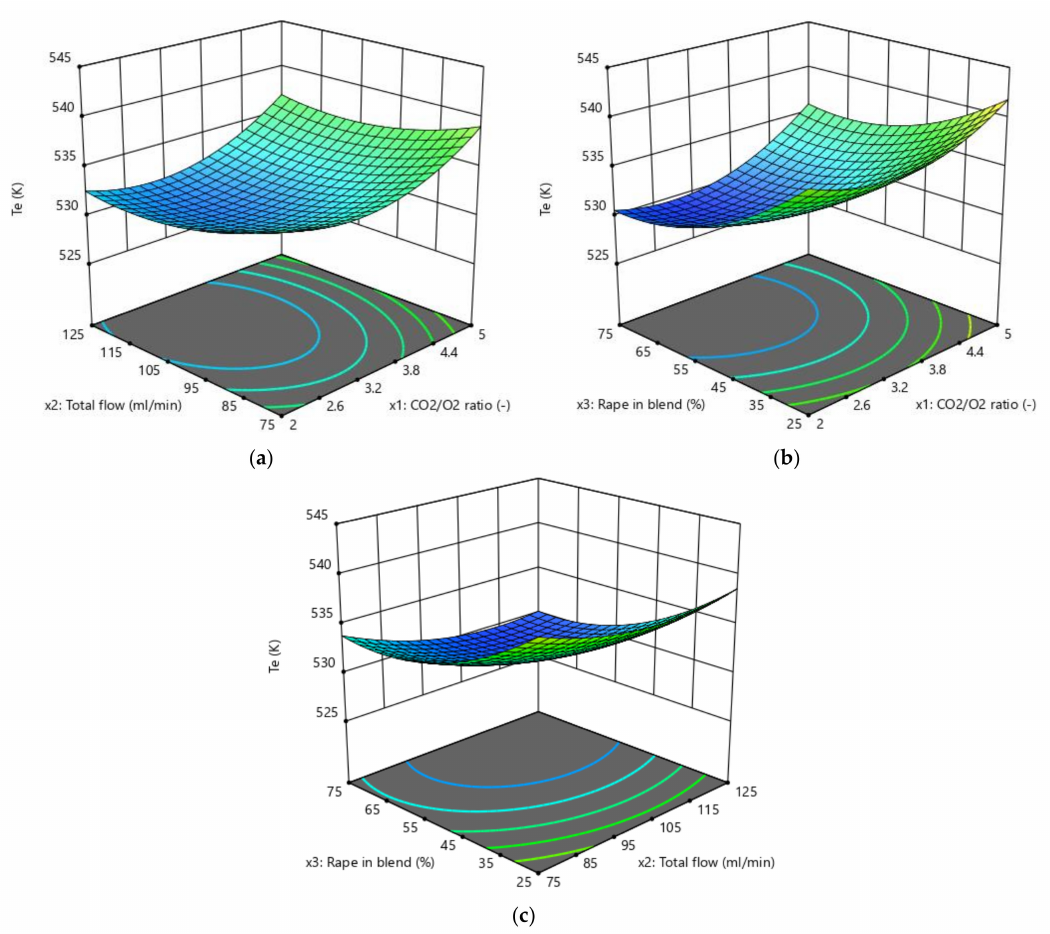
Figure 5. T e response surfaces for the central composite design ( a – c ).